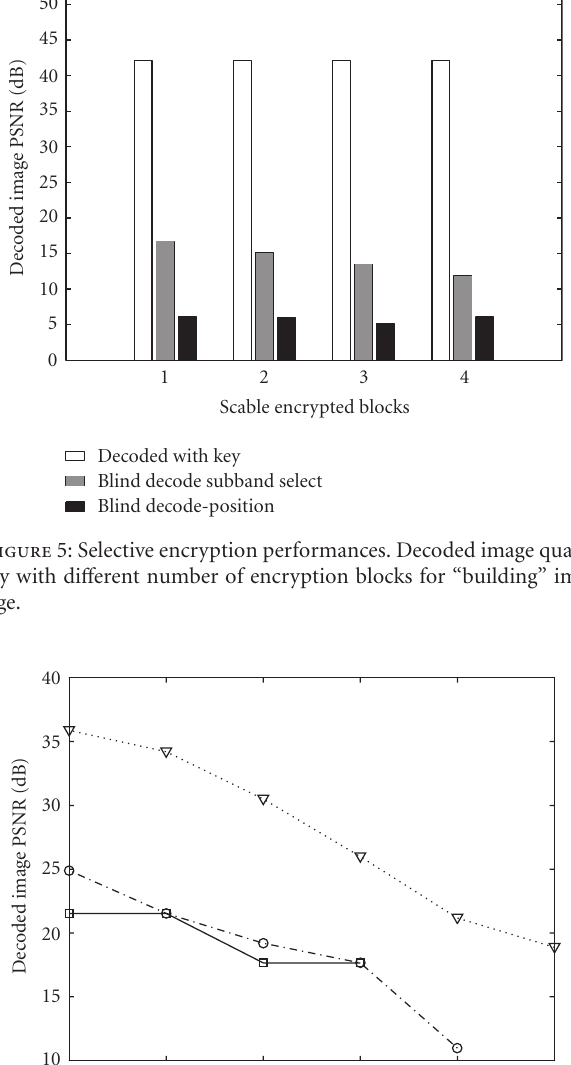
state factor is − 80 dB, 1.1626e-7 mJ energy is consumed per bit using the worst matched modulation scheme and trans- mission rate; 0.3265e-7 mJ energy is consumed by trans- mission using suboptimal matched modulation and trans- mission rate. However, the optimized transmission rate and modulation scheme achieves only 0.2899e-7 mJ energy con- sumption for each information bit. In this case, transmission rate and modulation optimization reduces 75% and 11% en- ergy saving than the worst case and suboptimal transmission ones,